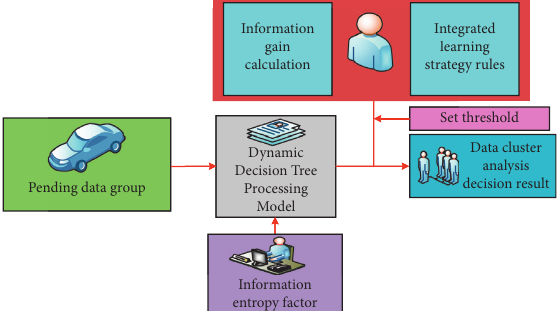
Figure 1: The process of analyzing data by dynamic decision